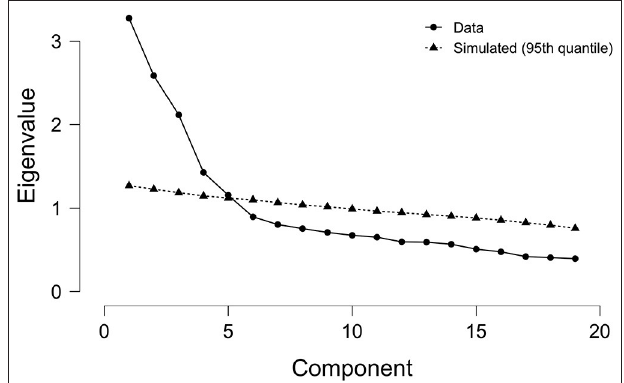
FIGURE 1 | A scree plot from Horn’s parallel analysis method supporting a five-factor solution.